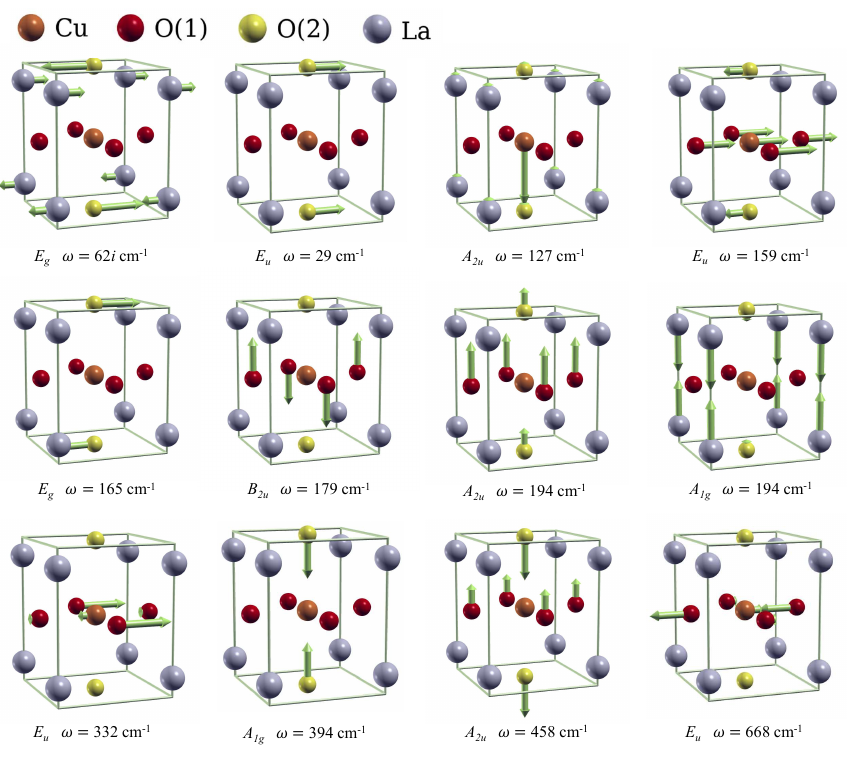
Figure A1: All optical LCO modes at the Γ point.